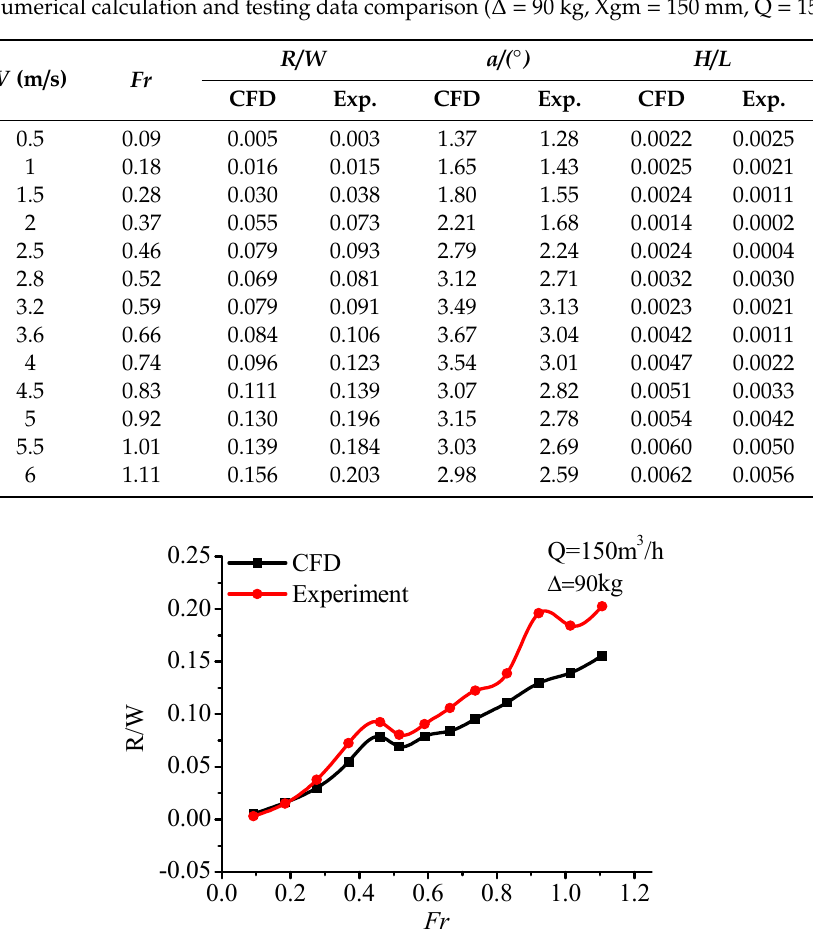
Table 4. Numerical calculation and testing data comparison ( ∆ = 90 kg, Xgm = 150 mm, Q = 150 m 3 / h).